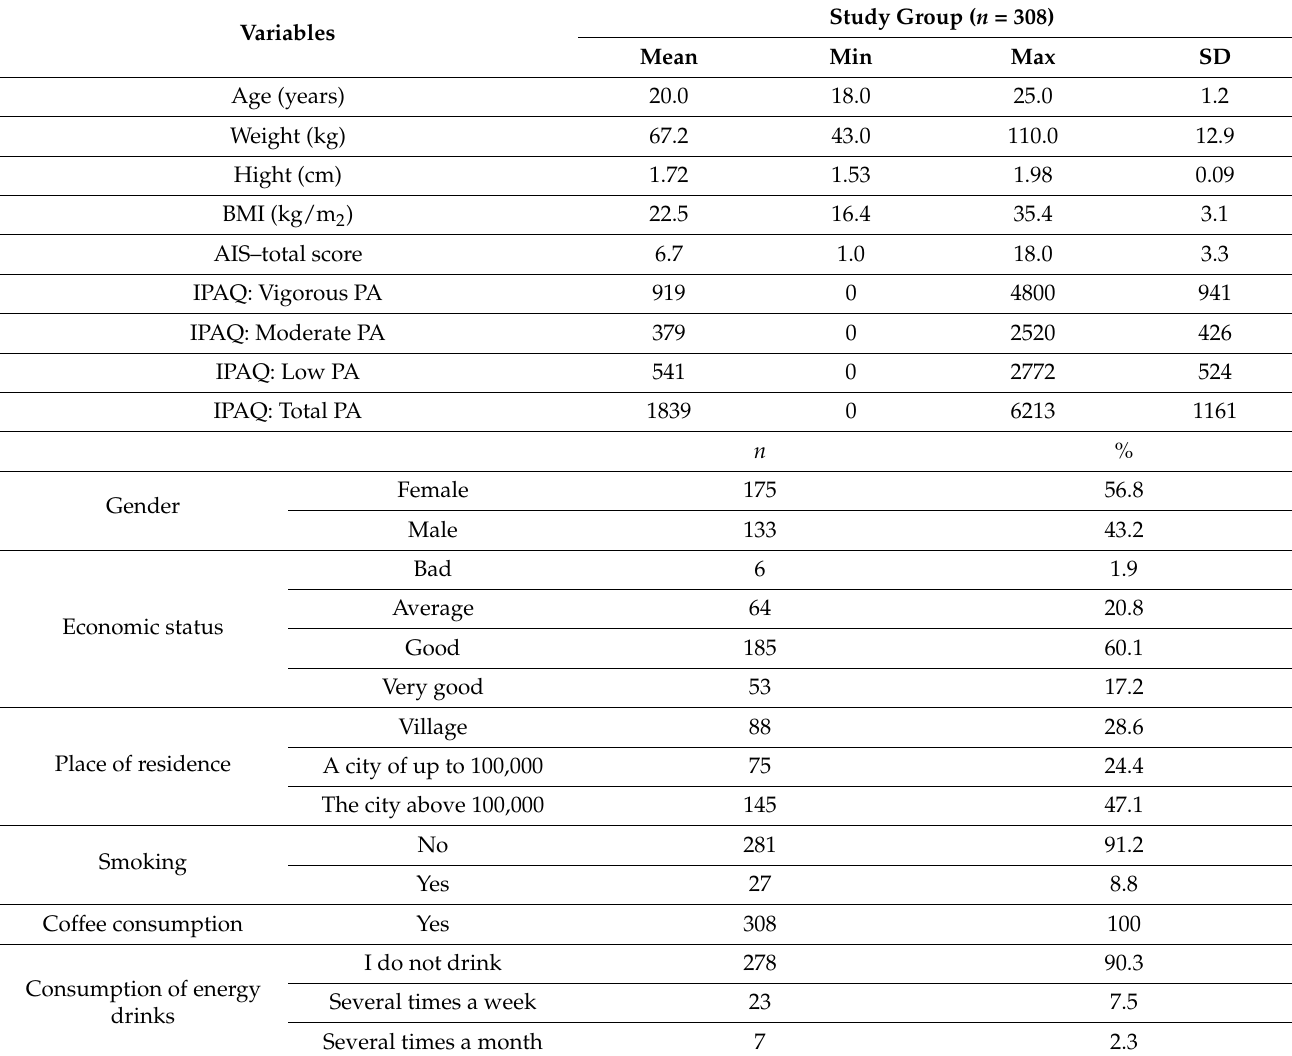
Table 1. Characteristics of the study